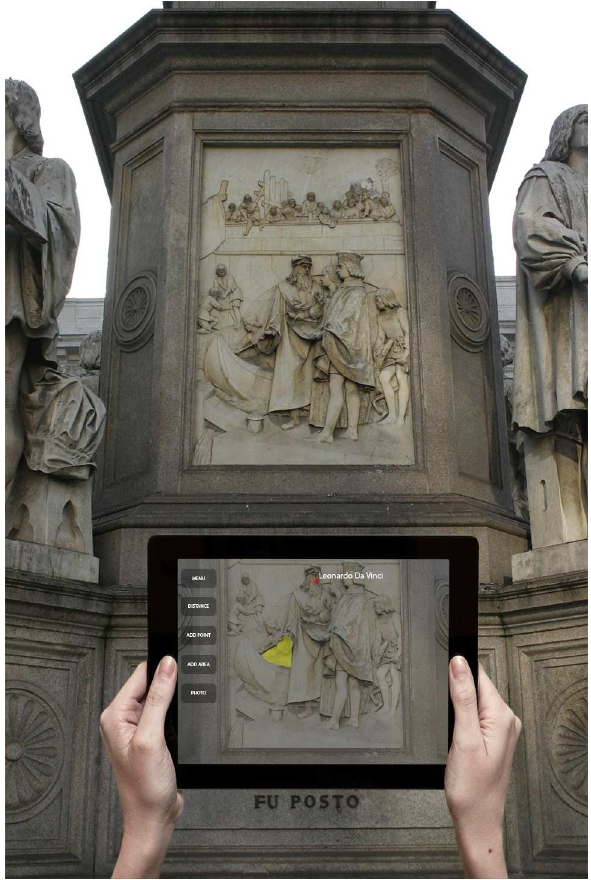
Figure 7. Use of the mobile application on the statue of Leonardo da